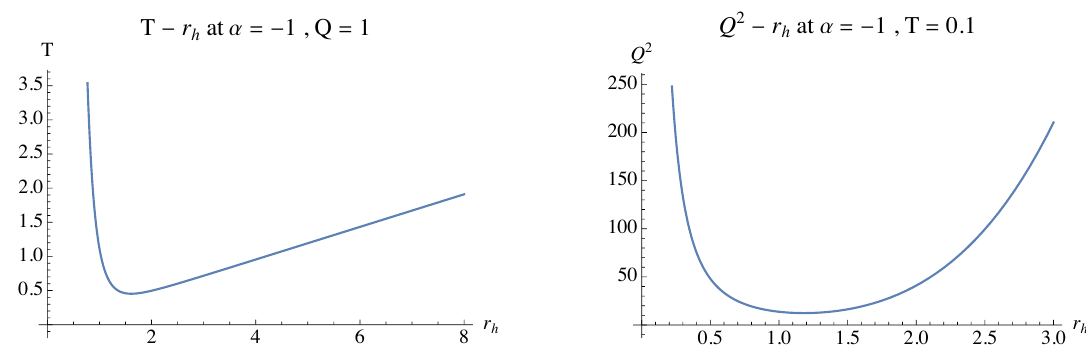
Figure 1 . The left plot: T vs r h with fixed Q and α . Apparently, T has a lower bound here. The right plot: Q versus r h with fixed T and α . Q has a lower bound